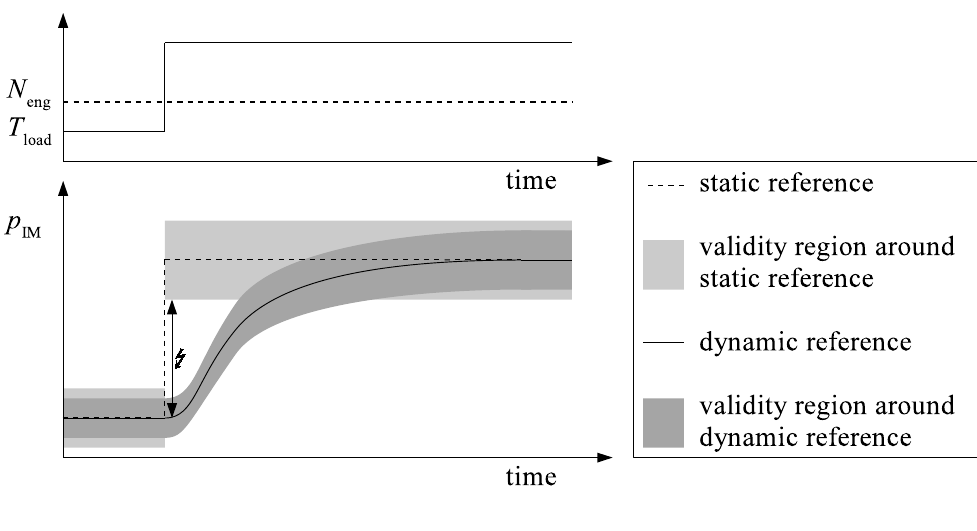
Figure 4. Exemplary static and dynamic references over a load step, and the validity regions of the corresponding setpoint-relative